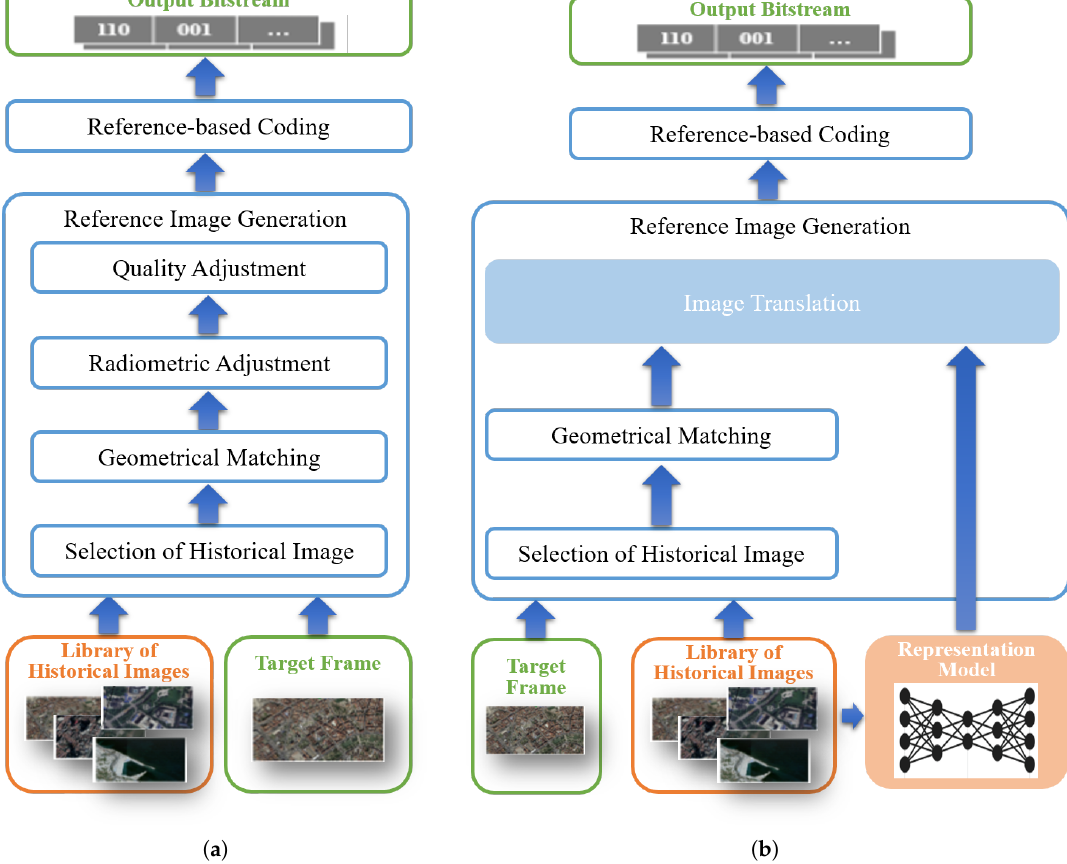
Figure 1. Comparison of the overall-frameworks. ( a ) The framework proposed in the previous method [2]; ( b ) the proposed process in this paper.